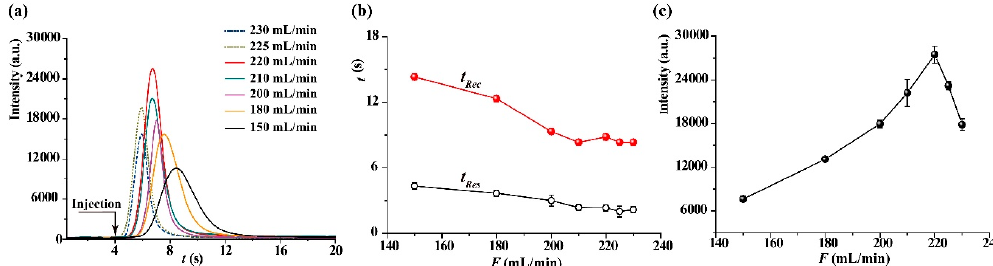
Figure 4. ( a ) The dynamic response curves of 2-butanone under different flow rates. ( b ) The change trends of t Res and t Rec versus flow rate. ( c ) The relationship between S value and flow rate. Wavelength: 440nm, temperature: 231 °C, the concentration of 2-butanone is 200 mg/m 3 .